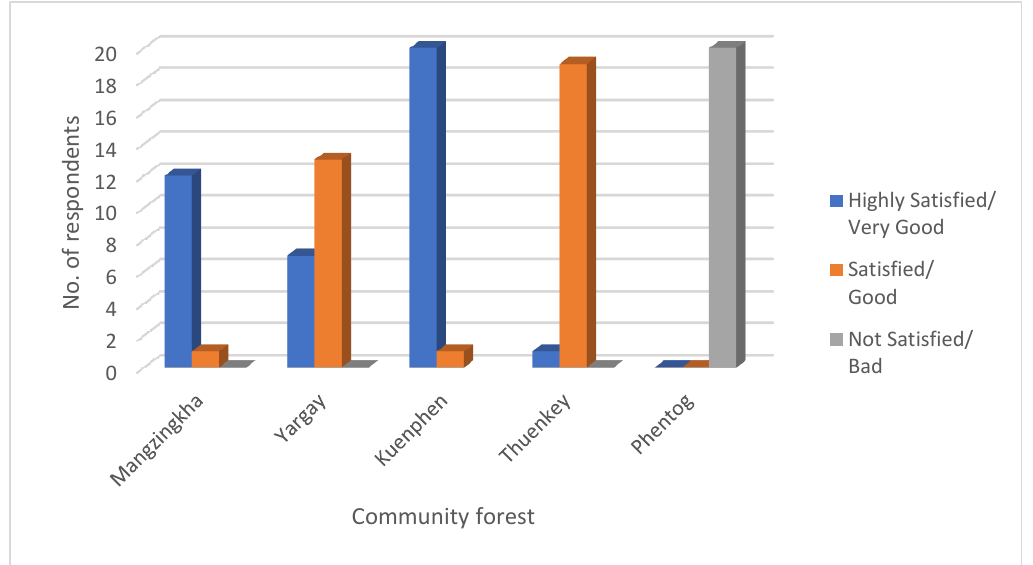
Figure 4. Level of satisfaction of the community forest management group (CFMG) members about their plantations in five villages in Punakha dzongkhag.